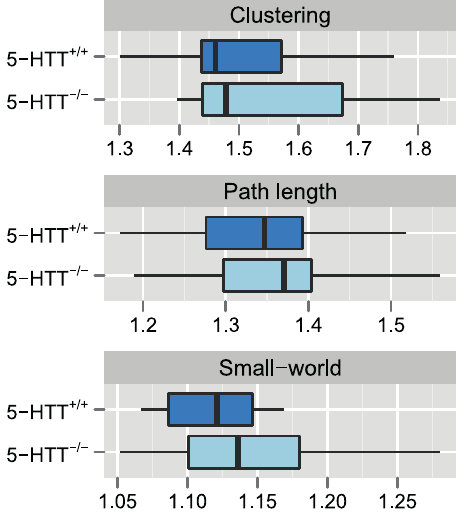
Figure 3. Network parameters from seed-based graph analysis of resting-state fMRI functional connectivity. Functional brain networks were constructed from seed-based resting-state fMRI functional connectivity values. The boxplots display three global network parameters that capture key properties of the functional brain networks, and were calculated on weighted graphs: the clustering coefficient (i.e., average of local clustering coefficients), the character- istic path length (i.e., average of shortest path lengths), and the small- worldness (i.e., ratio of normalized clustering coefficient and normalized characteristic path